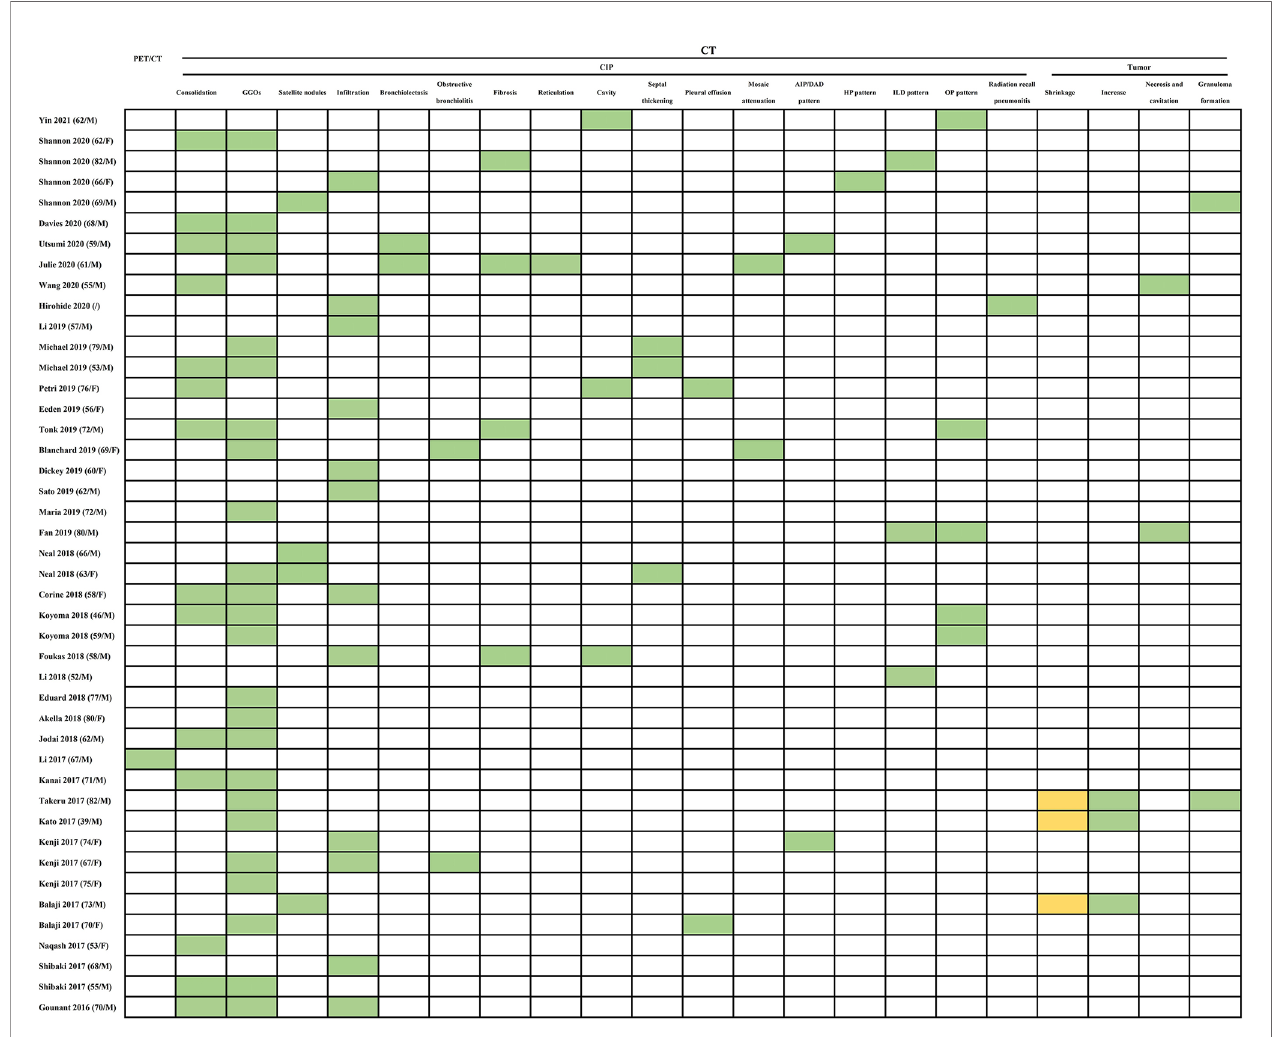
FIGURE 2 | Summarized results of radiological tests for diagnosis in published cases reports/case series. The radiological tests include PET/CT and CT fi ndings. PET/CT, positron emission tomography/computed tomography; CT, computed tomography; GGOs, ground-glass opacities; AIP/DAD, Acute interstitial pneumonia (AIP)/diffuse alveolar damage (DAD); HP, hypersensitivity pneumonitis; ILD, interstitial lung disease; OP, organizing pneumonia. Abnormal: green grid; normal: orange grid; undone: white